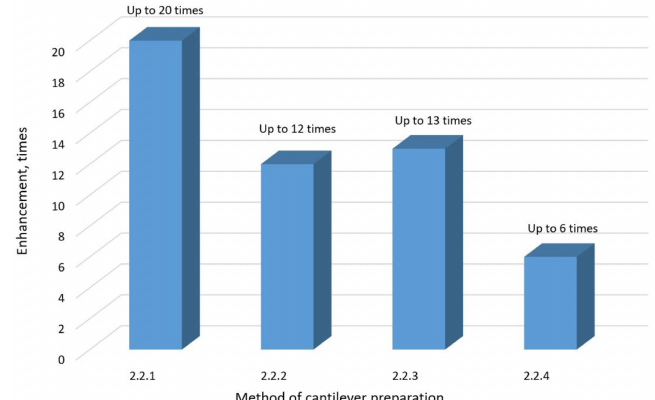
Figure 10. The comparison of the relative enhancement of Raman signal observed with Au TERS probes prepared by different methods. The presented results respond to analyte molecule GO. The results can vary depending on the analyte molecule type.